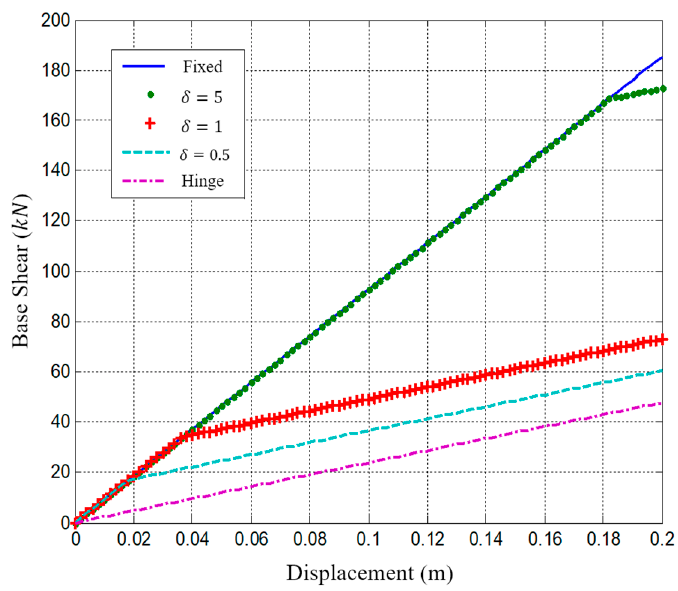
Figure 7. Load–displacement response of SDOF model.